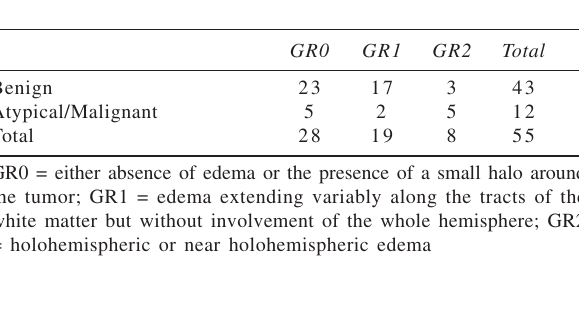
Table 1 - Type of meningioma versus peritumoral edema using Magnetic resonance imaging and brain computer tomography. There was a statistically significant correlation between the histological features and extent of peritumoral brain edema ( P = .0089, chi-square test).